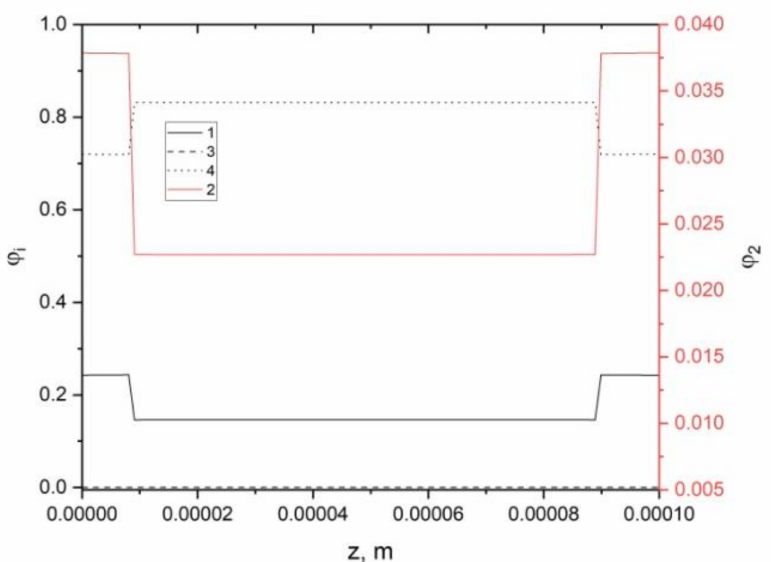
Figure 11. Distribution of volume fractions of phases under the influence of a low-intensity surface forest fire depending on the thickness of the leaf at time t = 5 s (autumn, October, +0 ◦ C, ϕ 30 = 0.4, α s = 0.05): 1—dry organic matter, 2—soot particles, 3—moisture, 4—gas.